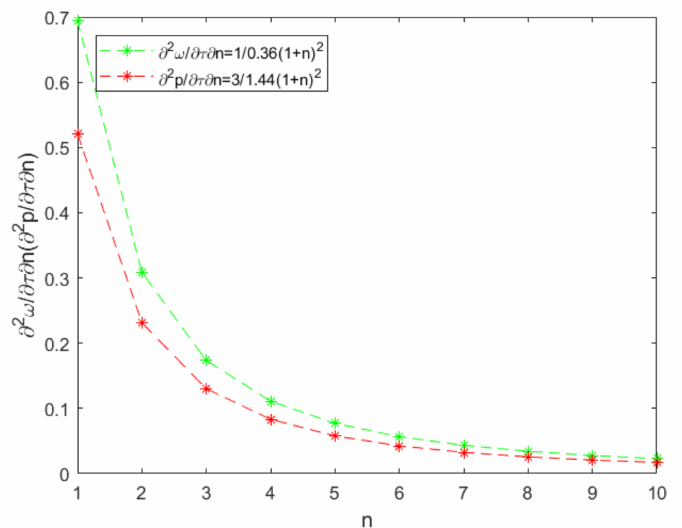
Figure 10. Relationship between the rate of change for products in upstream and downstream countries with regard to changes in the ad valorem tax and the degree of concentration in up- stream